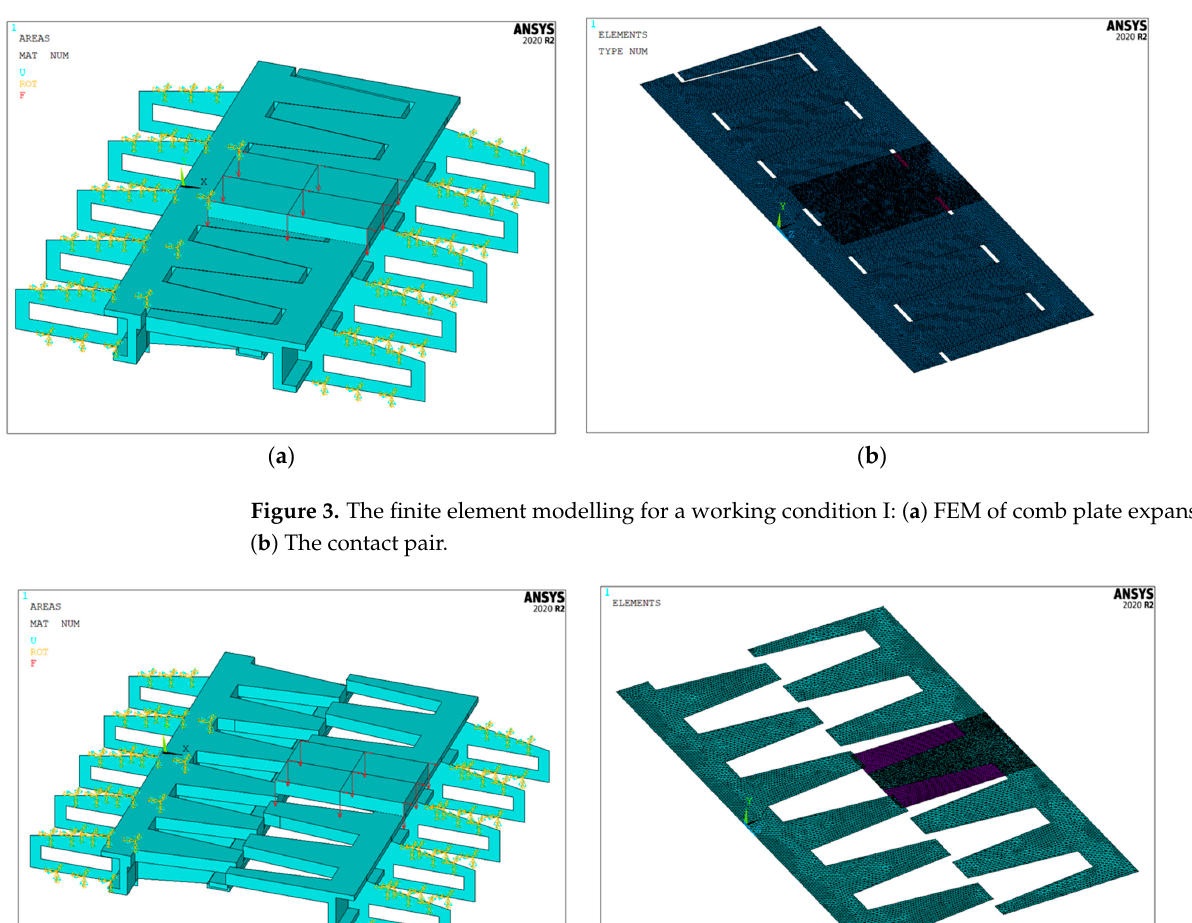
( b ) Figure 5. The finite element meshing for working conditions: ( a ) working condition I, ( b ) working condition II. 2.2.1. Stress Evaluation under Working Condition I and II by FEM As we can see from Figure 6, the maximum equivalent stress of the expansion device is 259.42 MPa under the working condition I. Moreover, the danger point is located at the connection between the movable plate and the middle anchor. For working condition II, as shown in Figure 7, the maximum equivalent stress of the expansion device is 284.64 MPa. The danger point is located at the connection between the fixed plate and the middle anchor. Therefore, the maximum equivalent stress of the expansion device under two work conditions is less than the permissible stress of 236 MPa for Q335 steel. The equivalent stress of structures is detailed in Table 2. Table 2. Results of the equivalent stress of the structure. Working Condition